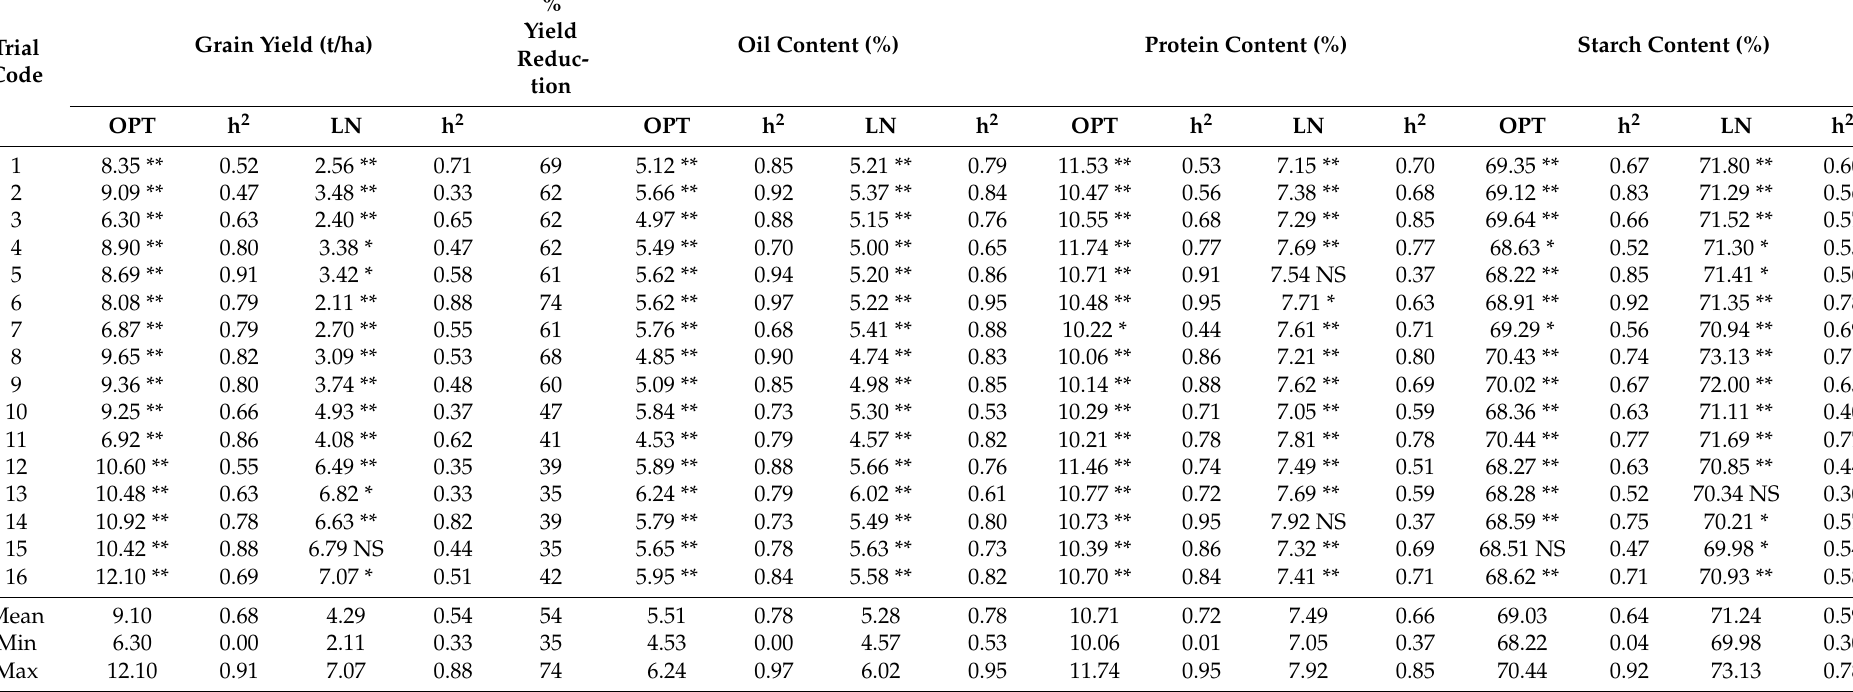
Table 2. Trial mean performance of genotypes for grain yield (GY), oil content, protein content and starch content, and their heritability estimates for 16 different trials evaluated under optimum and low-nitrogen conditions in Kiboko during 2011 to